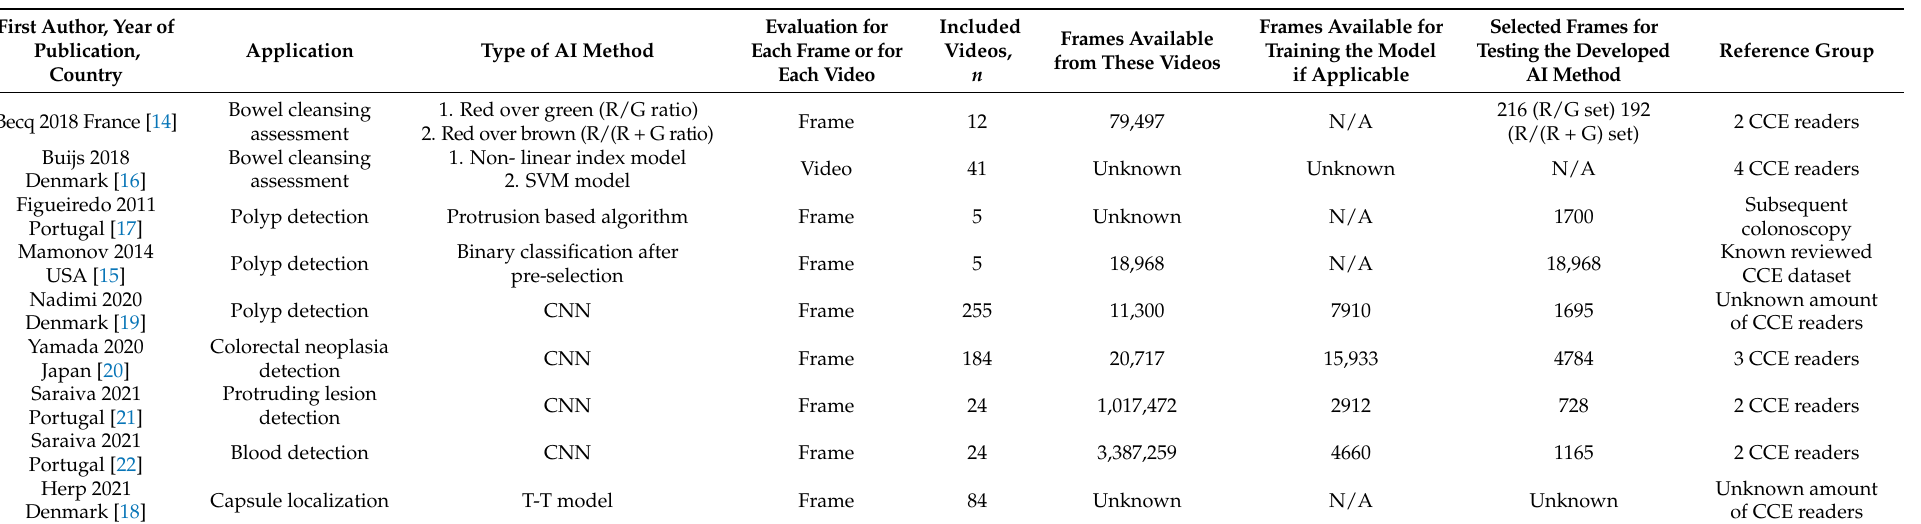
Table 2. Characteristics of the nine included